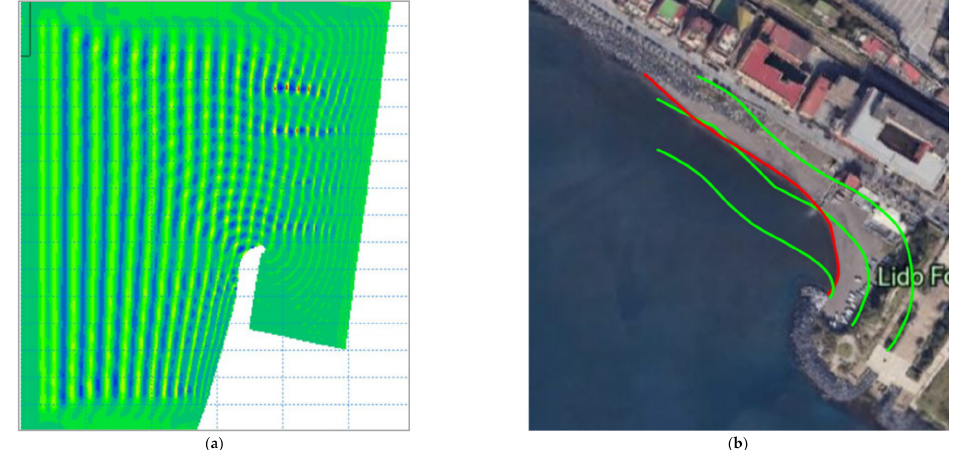
Figure 18. ( a ) Wave fronts generated by means BW; ( b ) comparisons between wave fronts (green lines) and shoreline (red line).